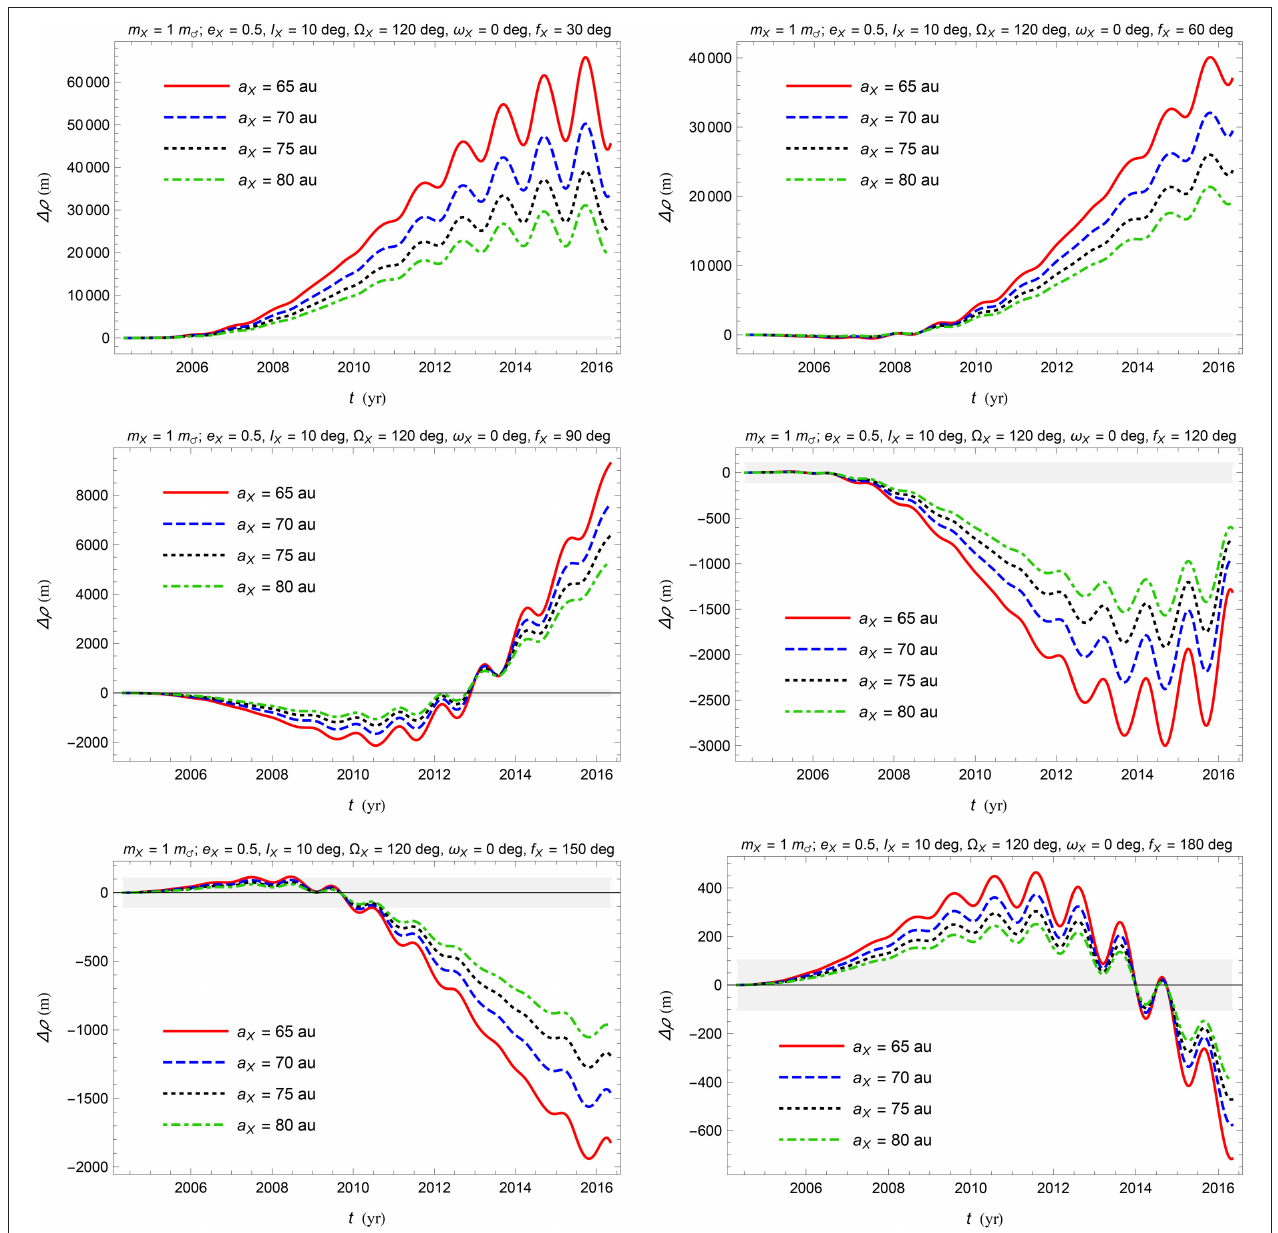
FIGURE 2 | Numerically simulated nominal Kronian range perturbation 1ρ ( t ) , in m, induced by a Mars-sized perturber PX (cid:0) m X = 1 m ♂ (cid:1) (Volk and Malhotra, 2017) over a time span 1 t = 12 year long for different values of its semimajor axis a X and true anomaly f X . PX is assumed to be located far from the perihelion ( f X ≫ 0 ◦ ) along a mildly inclined, eccentric ( e X = 0.5 ) orbit. The gray shaded horizontal band in each picture has a semi-amplitude of 100 m , and represents the “standard” post-fit range residuals of Saturn produced by processing the Cassini data without explicitly modeling the dynamics of any PX; cfr. with Figure 1 of Folkner et al. (2016).